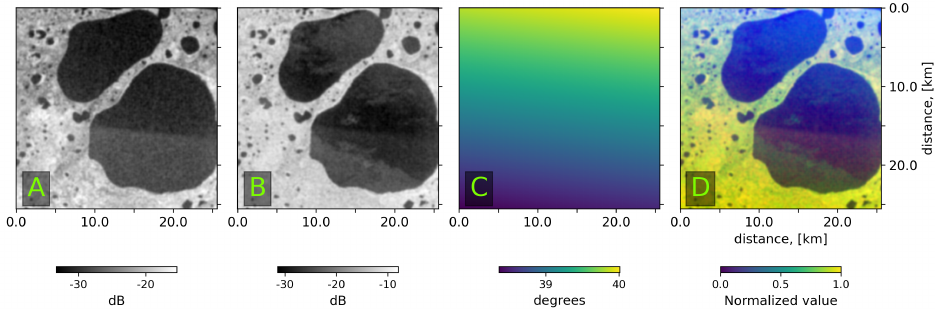
Figure 2. A pseudo-RGB image synthesized from Sentinel-1 data: ( A ) σ 0 at HV-polarization; ( B ) σ 0 at HH-polarization; ( C ) incidence angle ( I a ); ( D ) synthesized 3-channel image ( σ 0 normalized values in 0–1.